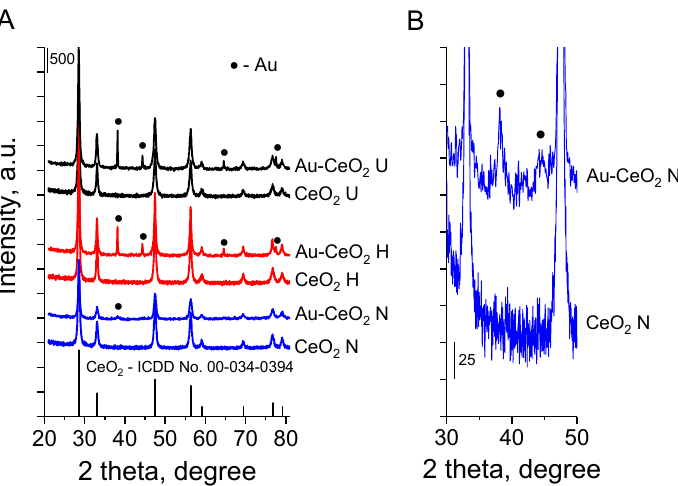
Figure 1. XRD patterns of as-synthesized materials ( A ) and XRD patterns recorded for materials pre- pared with the use of sodium hydroxide as a co-precipitation agent shown at higher magnification ( B